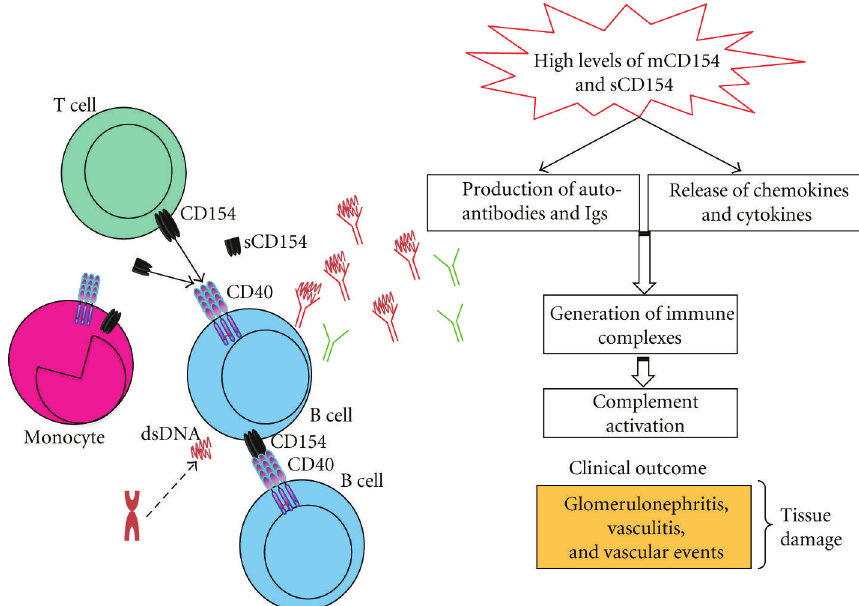
Figure 3: CD154-dependent mechanistic events in SLE patients. High levels of membrane bound and sCD154 activate various immune cells in SLE, including T cells, B cells, and monocytes. These CD154 interactions induce the release of inflammatory mediators and the production of autoantibody and Igs, leading to the generation of immune complexes and the activation of the complement system at the forefront of many clinical manifestations in SLE